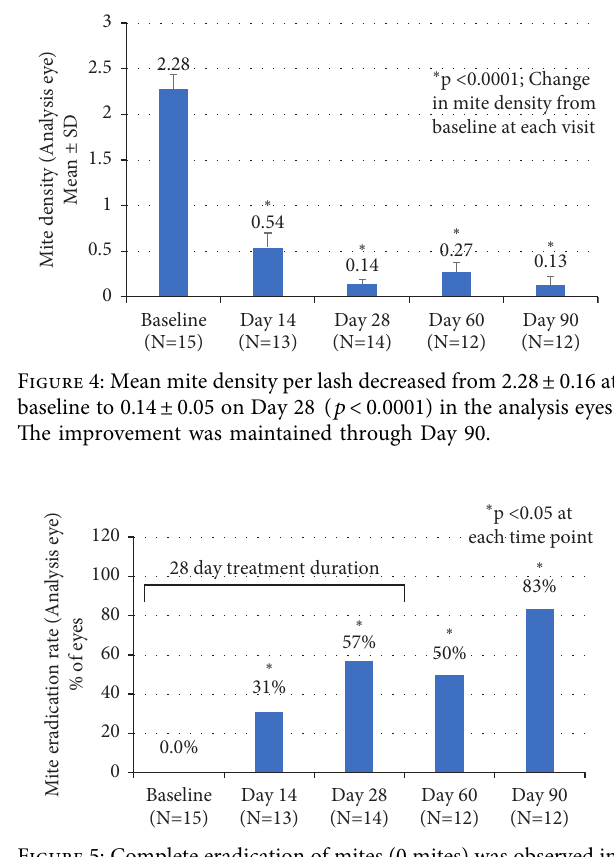
Figure 5: Complete eradication of mites (0 mites) was observed in 8 of 14 eyes (57.1%) on Day 28 and 10 of 12 eyes (83.3%) on Day 90.